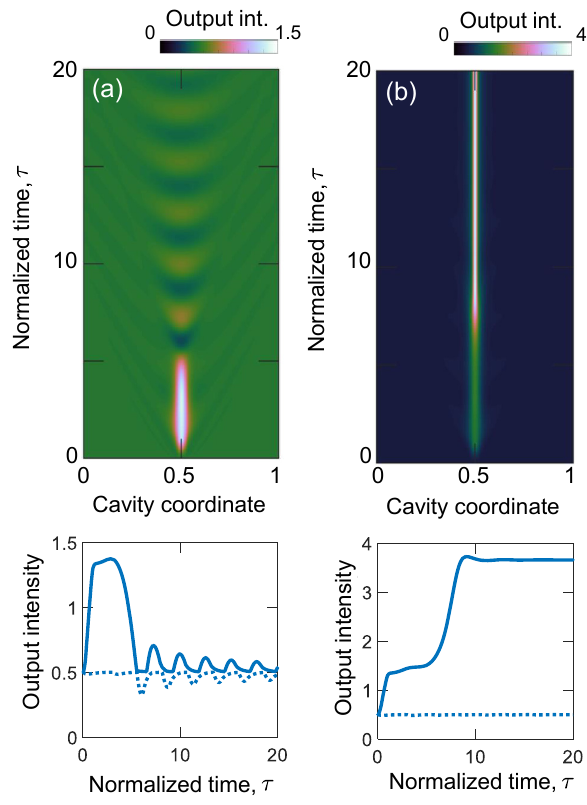
Figure 6: Y = 7. (a) Frustrated cavity soliton (CS) switching. The pulse width and duration are ϵ = 0.5 and T = 0.88, respectively. The local fi eld maximum does not evolve to a stable CS and rings off in rippling waves. (b) CS switch-on. Here the pulse width and duration are ϵ = 0.5 and T = 0.89 where T is just above the critical switch-on value. Space-time diagrams (upper panels) and output intensity vs time (bottom panels) are reported in both cases.